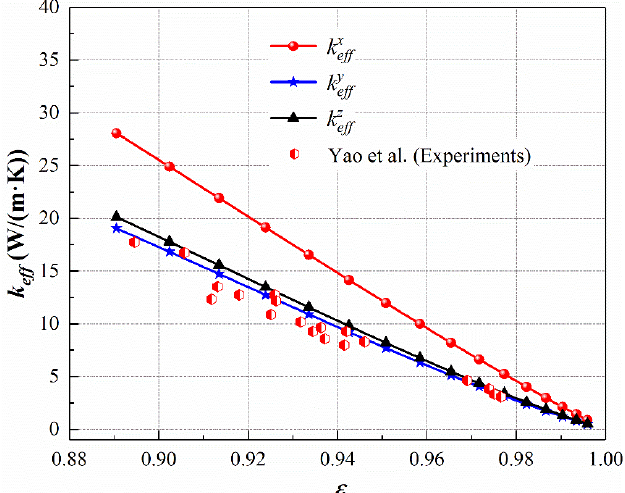
Figure 9. Comparisons between anisotropic model prediction and experimental data with copper foam and air ( k r = 15,132.08) [22].